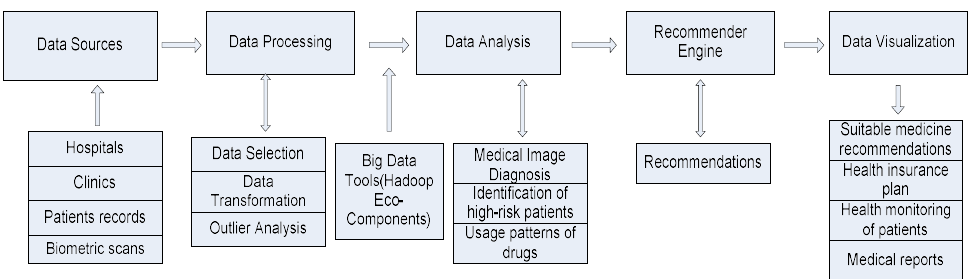
Figure 6. Health Recommender System Framework.